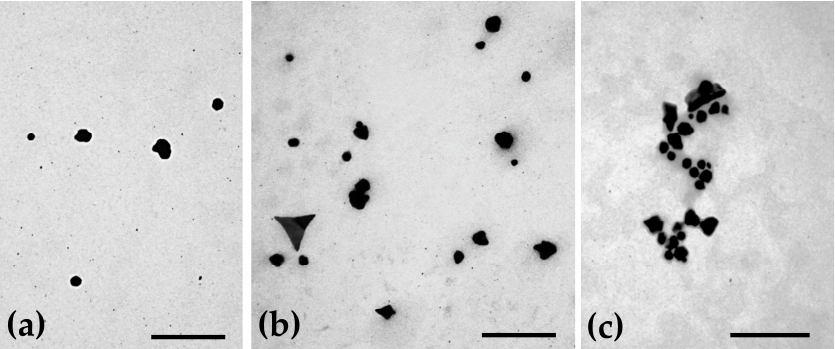
Figure 2. Representative transmission electron micrographs showing the morphology of ( a ) uncoated AuNPs, ( b ) HAOA-AuNPs (1:1) and ( c ) BSA-AuNPs (0.25:1). Scale bars = 300 nm.